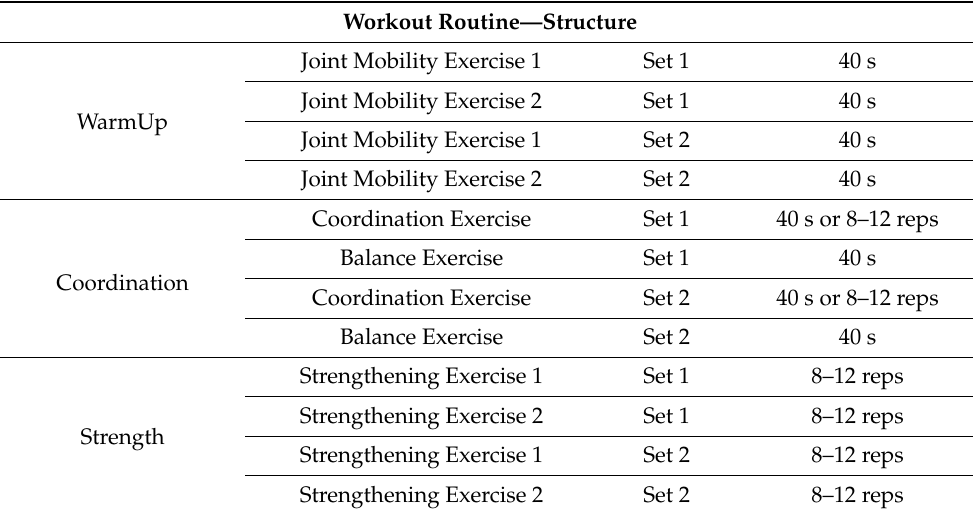
Table 1. Order of Main Motor Abilities Addressed in a 10-min Workout Routine. Workout